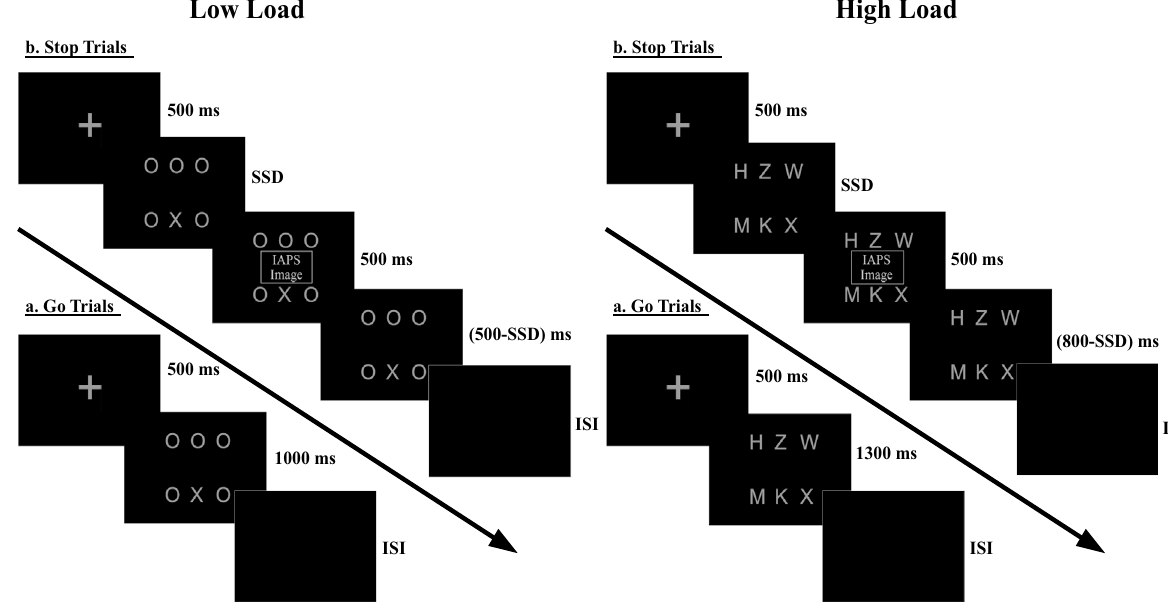
Figure 1. An example of go and stop trials. ( a ) During go trials, participants were required to press the 0 key for letter X and 2 key for letter N. ( b ) During stop-trials, after a variable delay from the onset of the go signal (SSD: Stop-Signal Delay), an image appeared at the centre of screen that signaled participant to withhold their motor response. Arousal matched positive, and negative IAPS images were used as stop-signal. The SSD was set based on a staircase procedure separately for each stop-signal condition to get stop-performance at approximately 50% correct. During low perceptual load trials, the target letter (X or N) was hidden among circular nontarget letters, while during high perceptual load, the target letter was hidden among angular nontarget letters. SSD: Stop- Signal